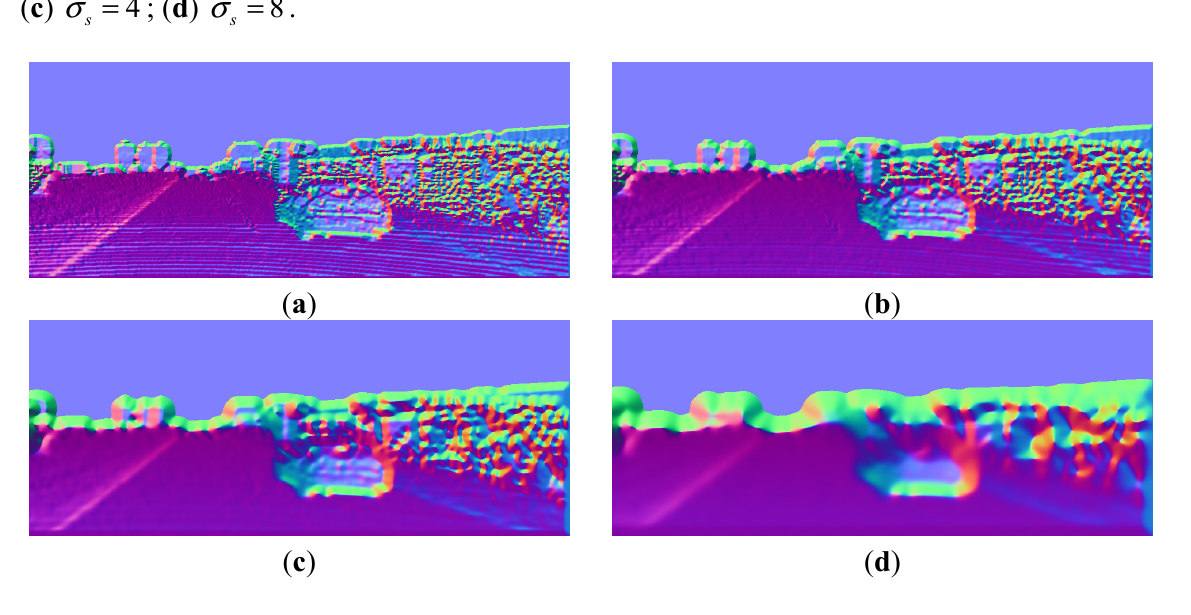
Figure 8. Normal images with different Gaussian kernels: ( a )